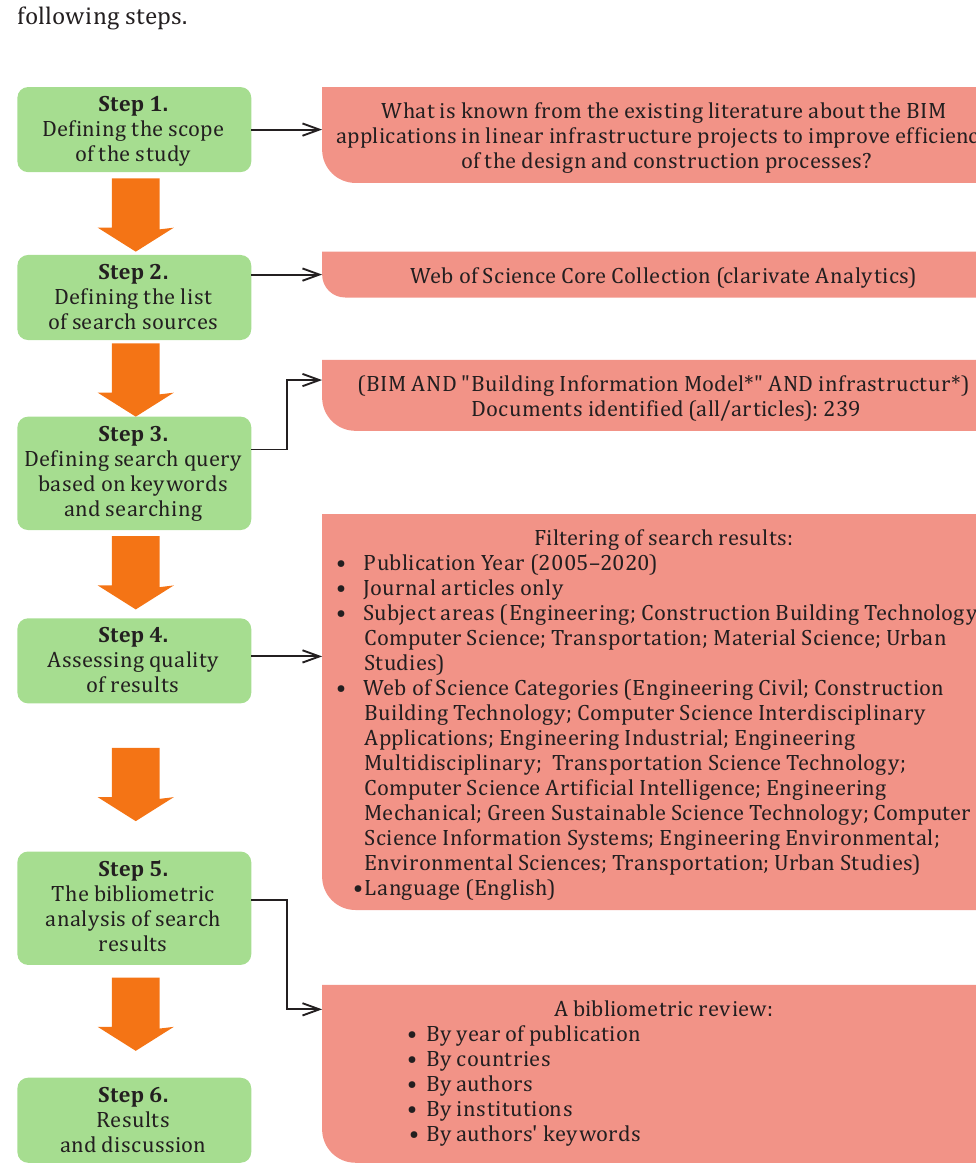
Figure 1. The research steps for a bibliometric analysis of the retrieved papers (created by the